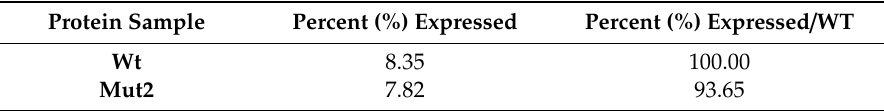
Table 4. Comparison of protein expression in Wt and Mut2 8S α globulin.